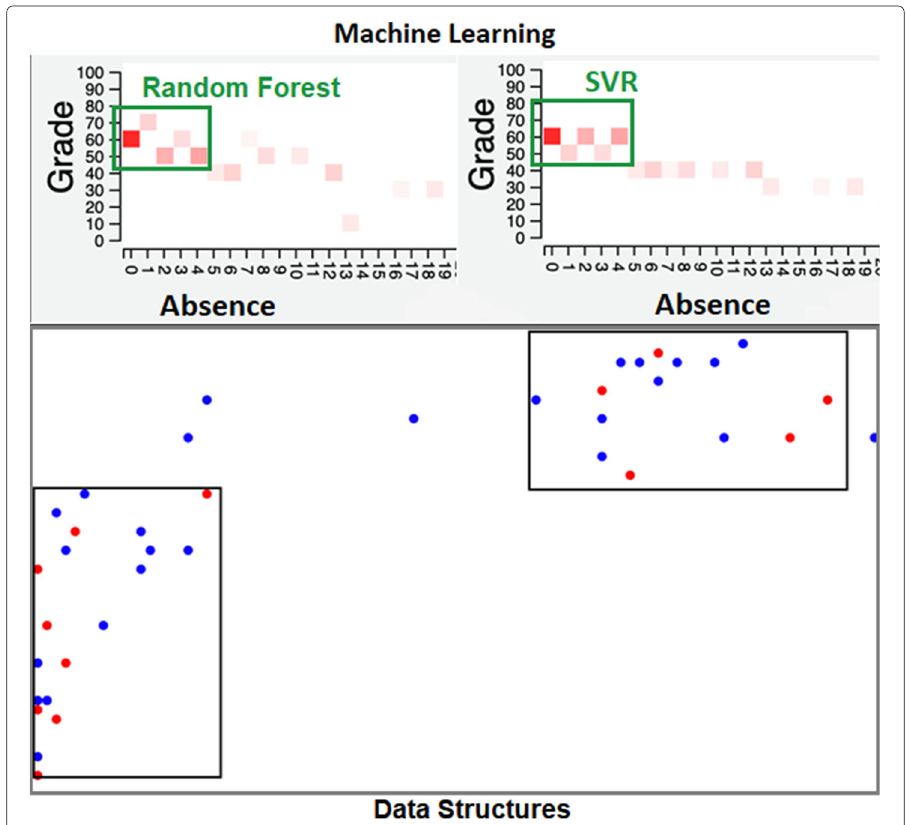
Fig. 16 Two clusters of students: the left one are composed of students with less absence and higher grades; the right one is composed of students with more absences and lower grades. These two patterns are also predicted in the layouts shown in Fig.